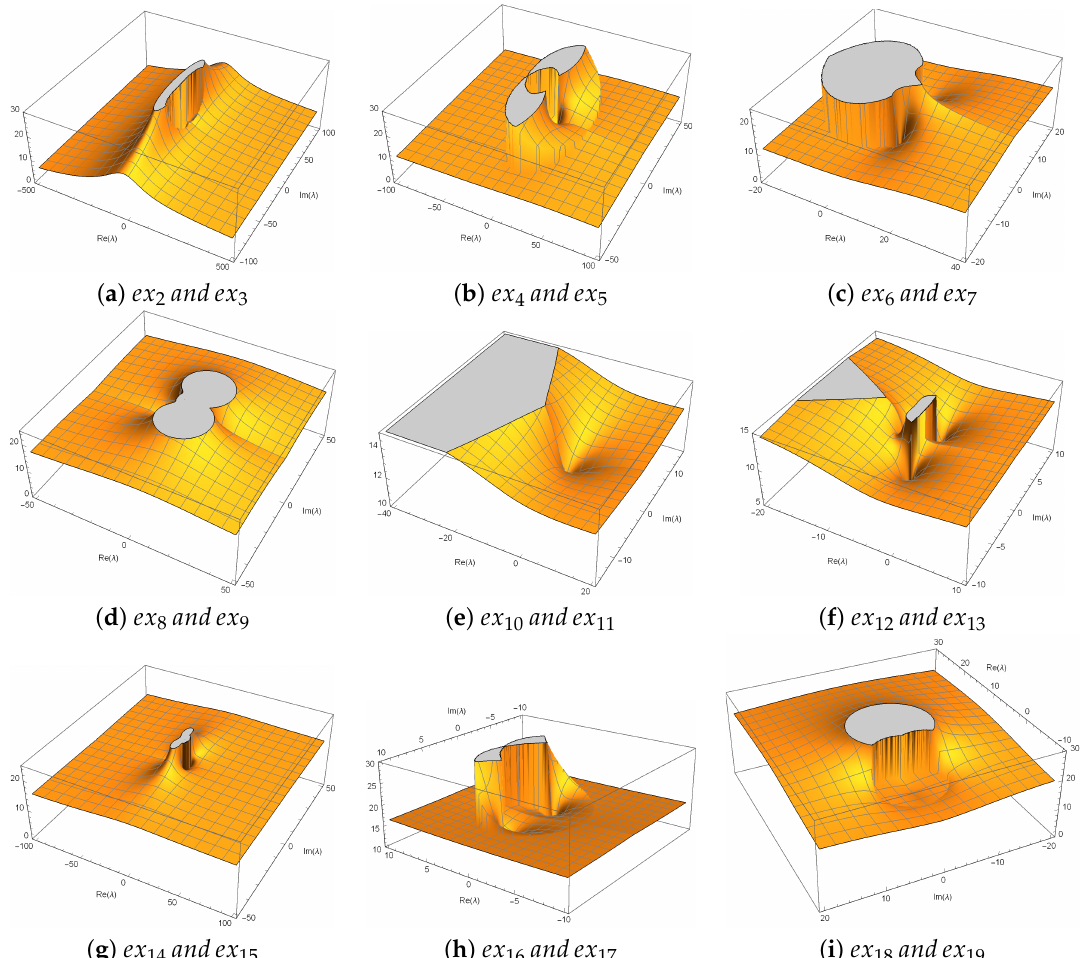
Figure 2. Stability surfaces of other strange fixed